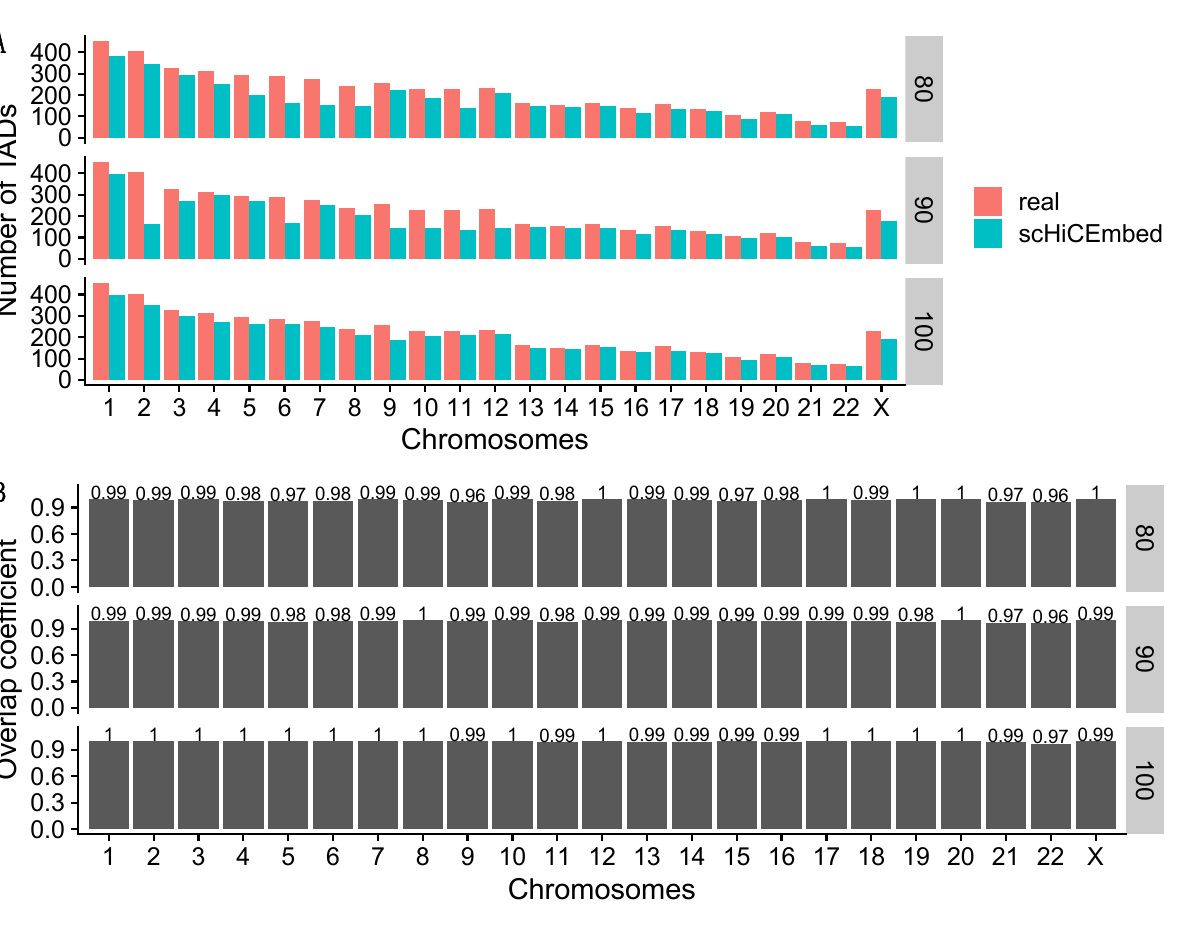
Figure 6. Results for detecting naïve TADs. ( A ) number of TADs in the real adjacency matrix and detected by scHiCEmbed with the three self-defined matrices (100%, 90%, and 80%) as input. ( B ) overlap coefficient between real and scHiCEmbed-detected TAD boundaries with allowing ± 1 bin mismatch.